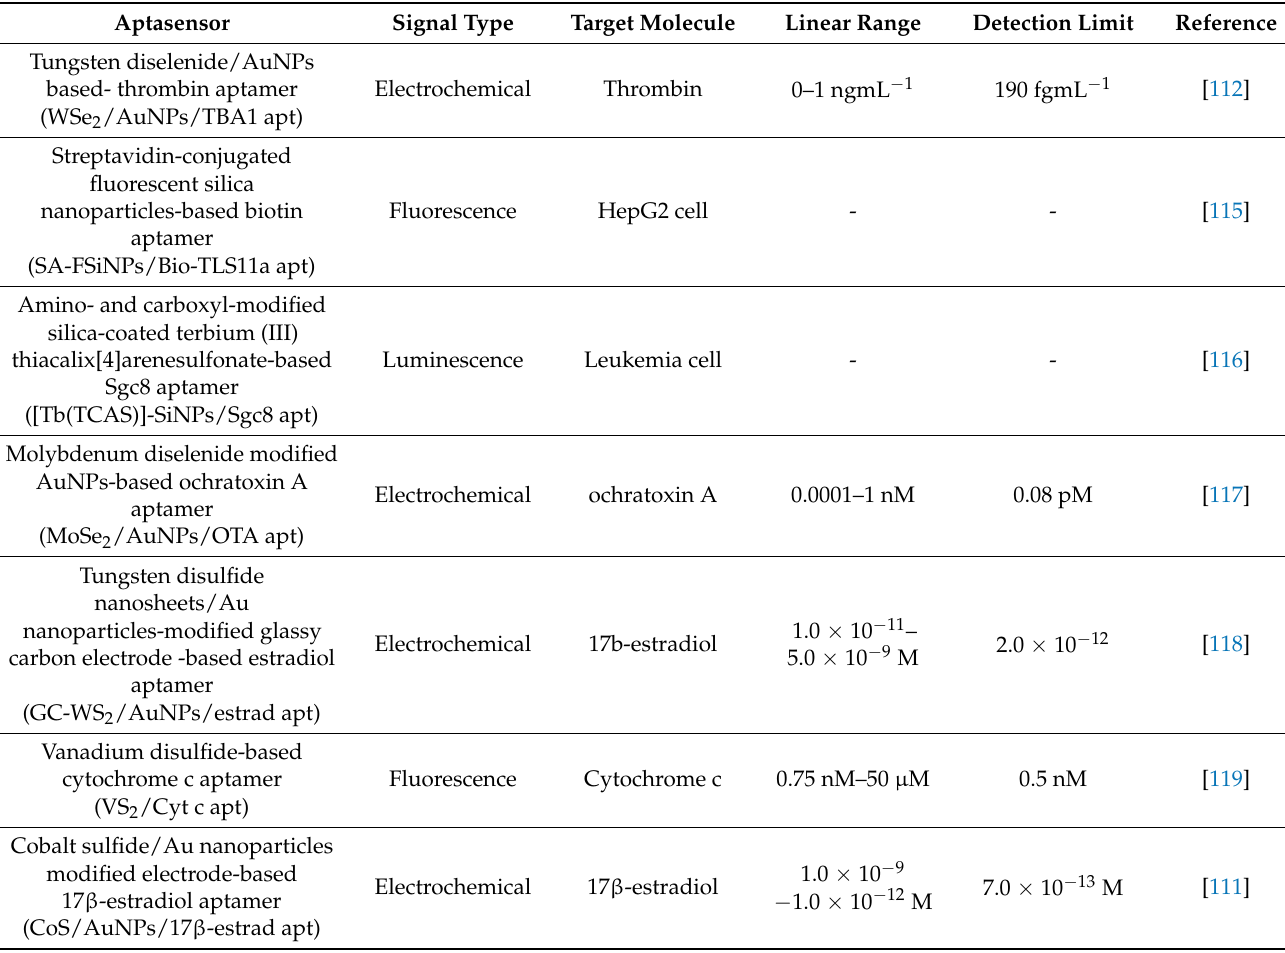
Table 3. Aptasensors fabricated on other types of